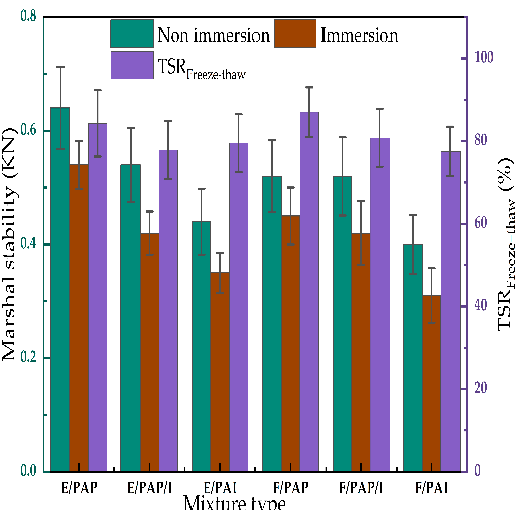
Figure 6. Freeze–thaw ITS test results of different CRMs. The freeze–thaw splitting test was also used to determine the optimum asphalt binder content in this study; the splitting strength and freeze–thaw splitting strength ratio (TSR freeze–thaw ) of E/RAP and F/RAP are depicted in Figure 7.